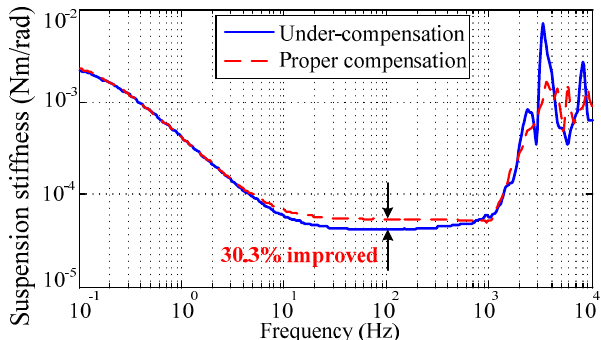
Figure 11. Experimental results of the suspension stiffness, which is improved by 30.3% with proper compensation.